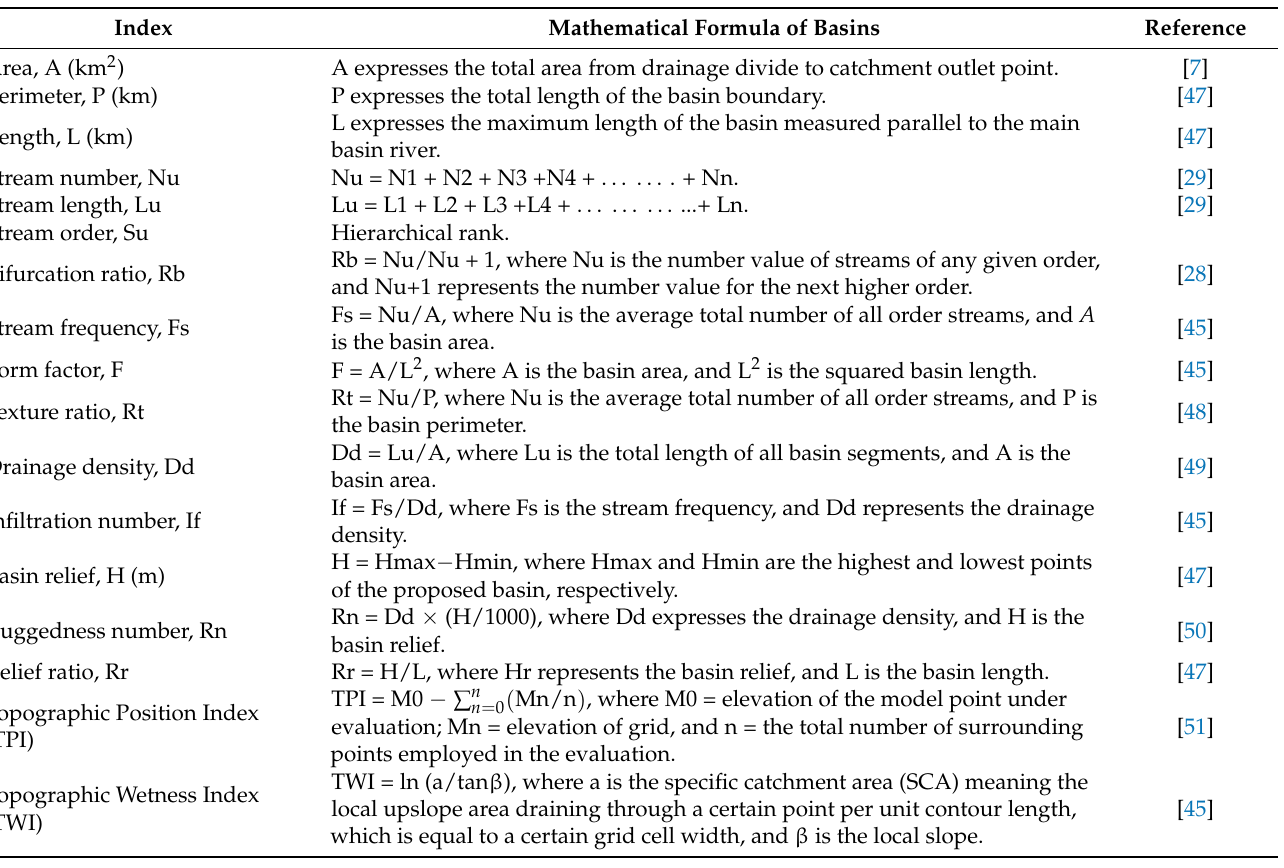
Table 2. Morphometric and topographic parameters.